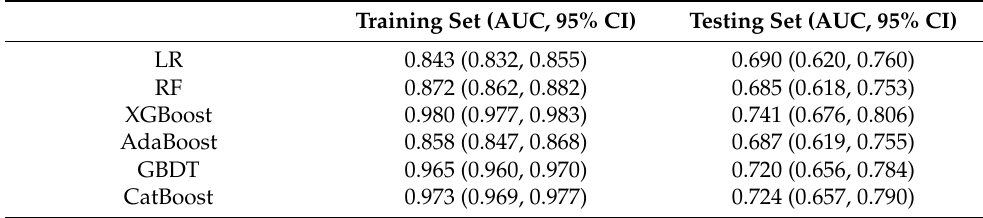
Figure 2. The receiver operating characteristic (ROC) curves of the machine learning models on the training set ( A ) and testing set ( B ). Table 2. The area under the curve (AUC) of training set and testing set.